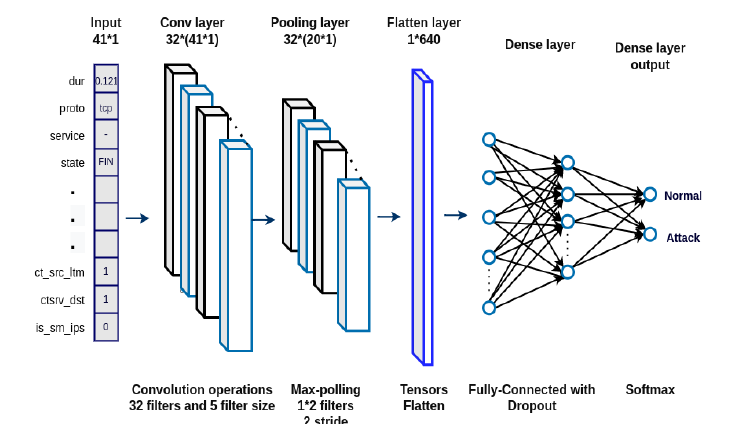
Figure 1. The single CNN architecture. The network includes following layers: input layer, one convolution layer, one max-pooling layer, two fully connected layers and output